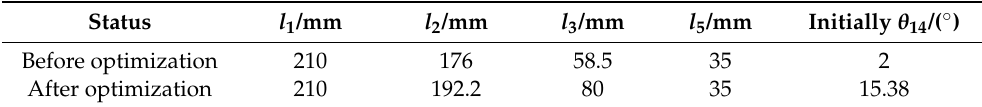
Table 3. Comparison of connecting rod parameters.